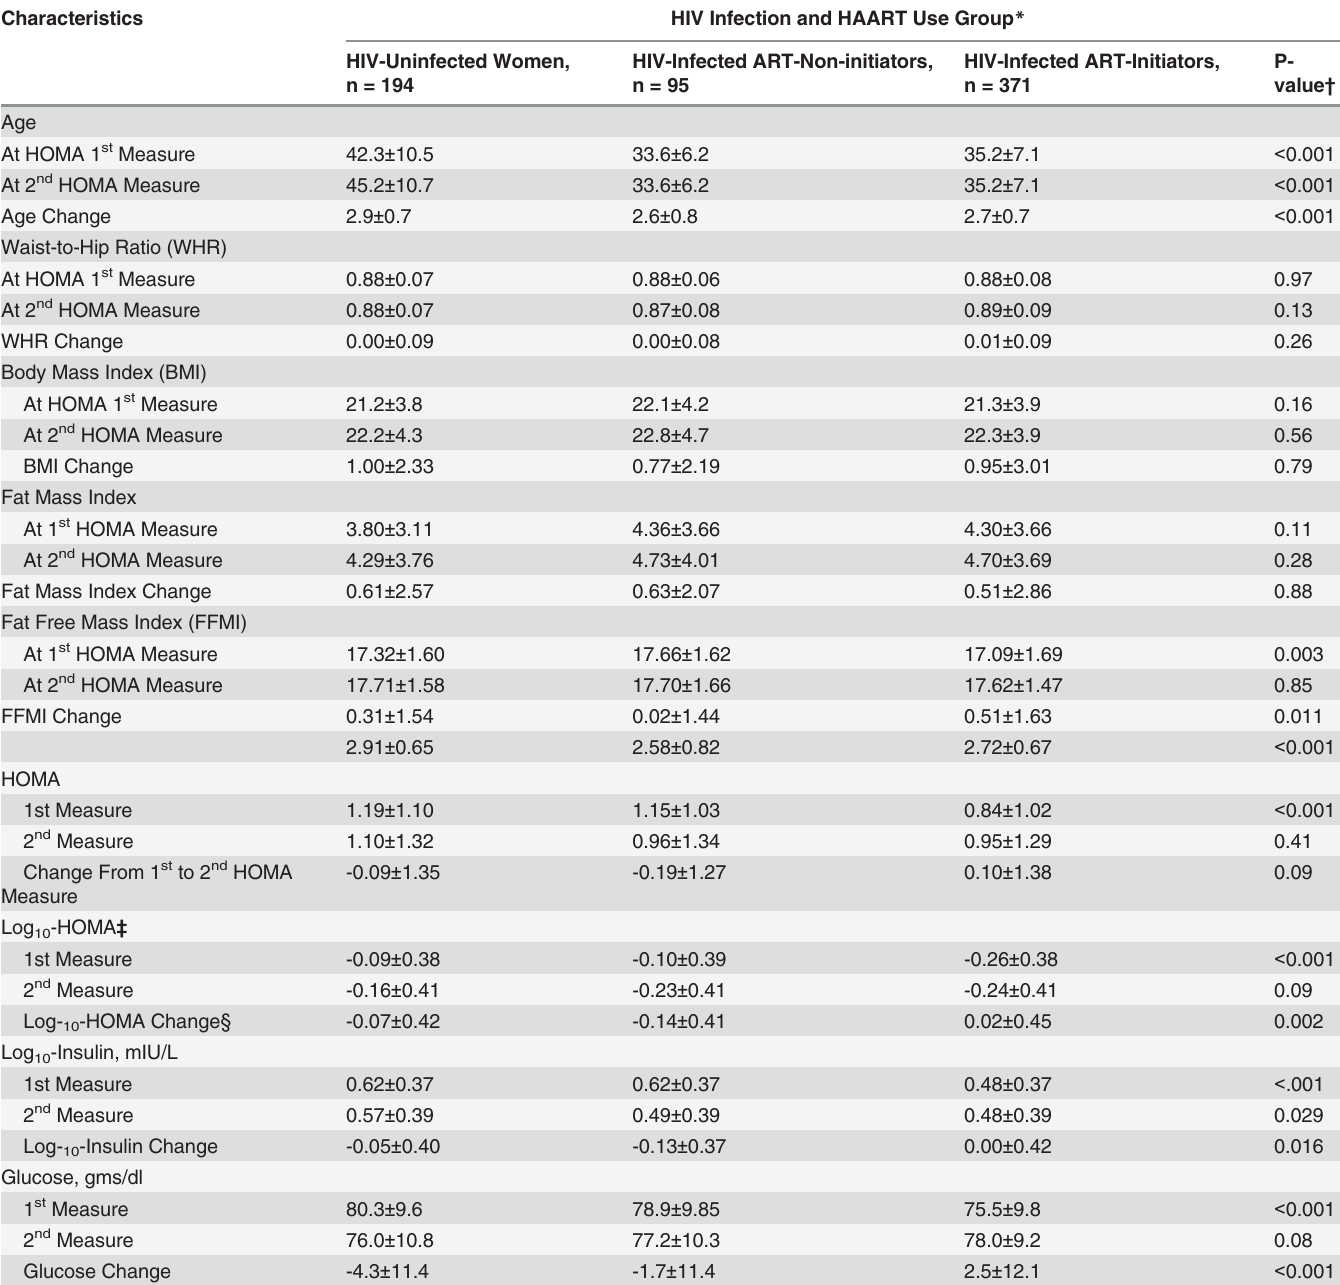
model among all women that included FFMI and FMI as predictors (instead of BMI and Table 1. Demographic and Clinical Characteristics of 660 RWISA Participants by HIV Status and ART Usage.